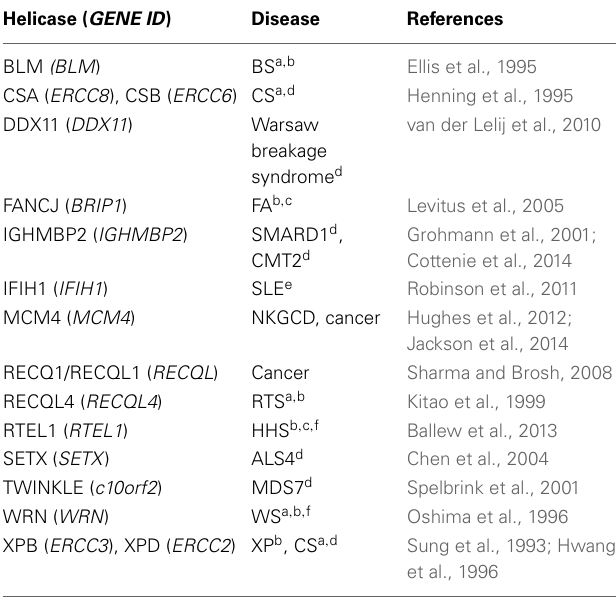
Table 1 | Helicases that associate with human